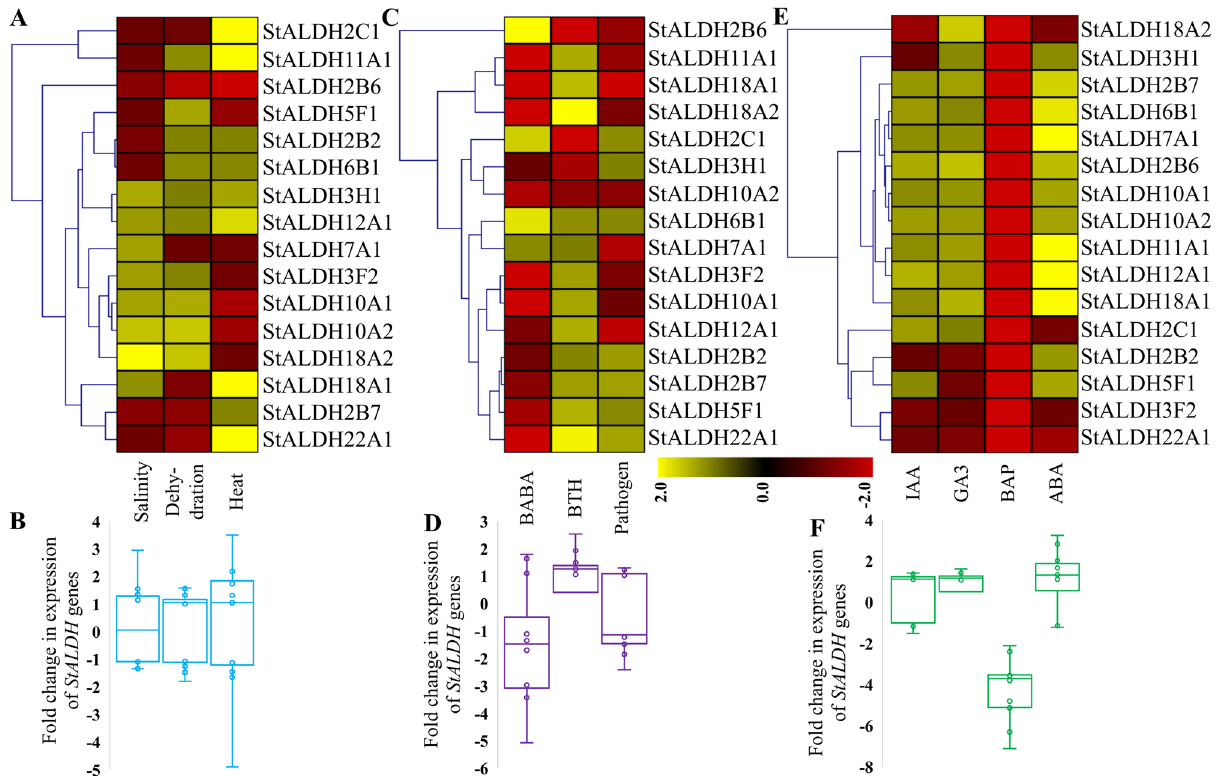
Figure 6. Expression analysis of StALDH genes upon environmental unfavorable conditions. The expression pattern of the 16 StALDH genes was investigated under various ( A , B ) Abiotic stresses, ( C , D ) Biotic elicitors, and ( E , F ) Hormonal treatments. Expression data were obtained from PGSC for three abiotic stresses such as salinity, dehydration, and heat; three biotic elicitors such as BABA, BTH, and pathogen; four hormonal treatments such as IAA, GA3, BAP, and ABA; and compared with their respective control samples to calculate the fold change in expression. Heatmap was created by hierarchical clustering of Manhattan distance correlation using MeV 4.9 software (http:// mev. tm4. org/). Colour scale represents fold changes, where yellow colour indicated upregulation and red colour indicated downregulation of individual gene. The box and whisker scatter plots below heatmaps showed the median fold change values of each